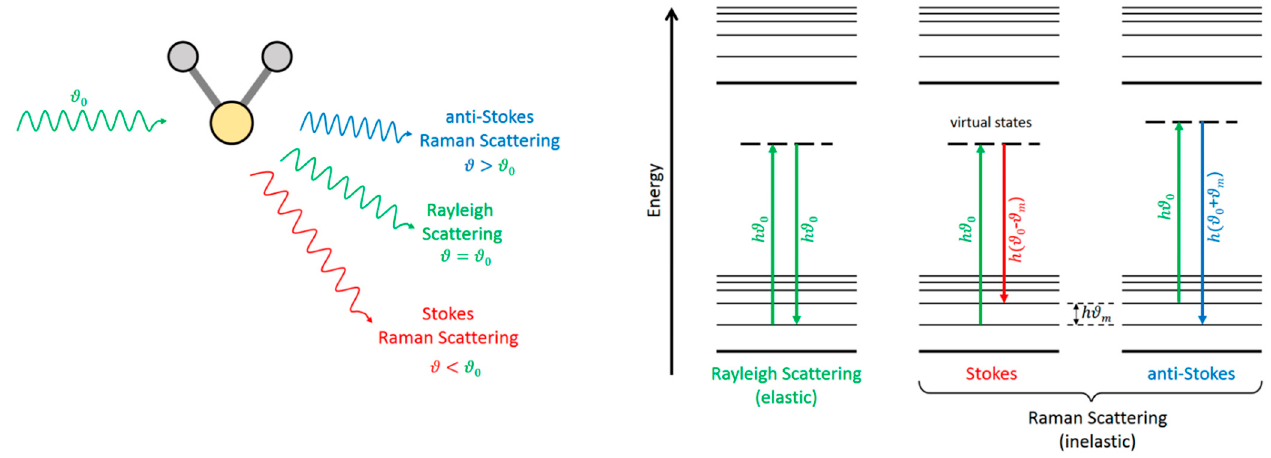
Figure 23. Illustration of Rayleigh and Raman (Stokes and anti-Stokes) scattering. In this figure, ϑ represents the wave frequency and h is the Planck constant. Subscript 0 refers to the incident pho- ton.